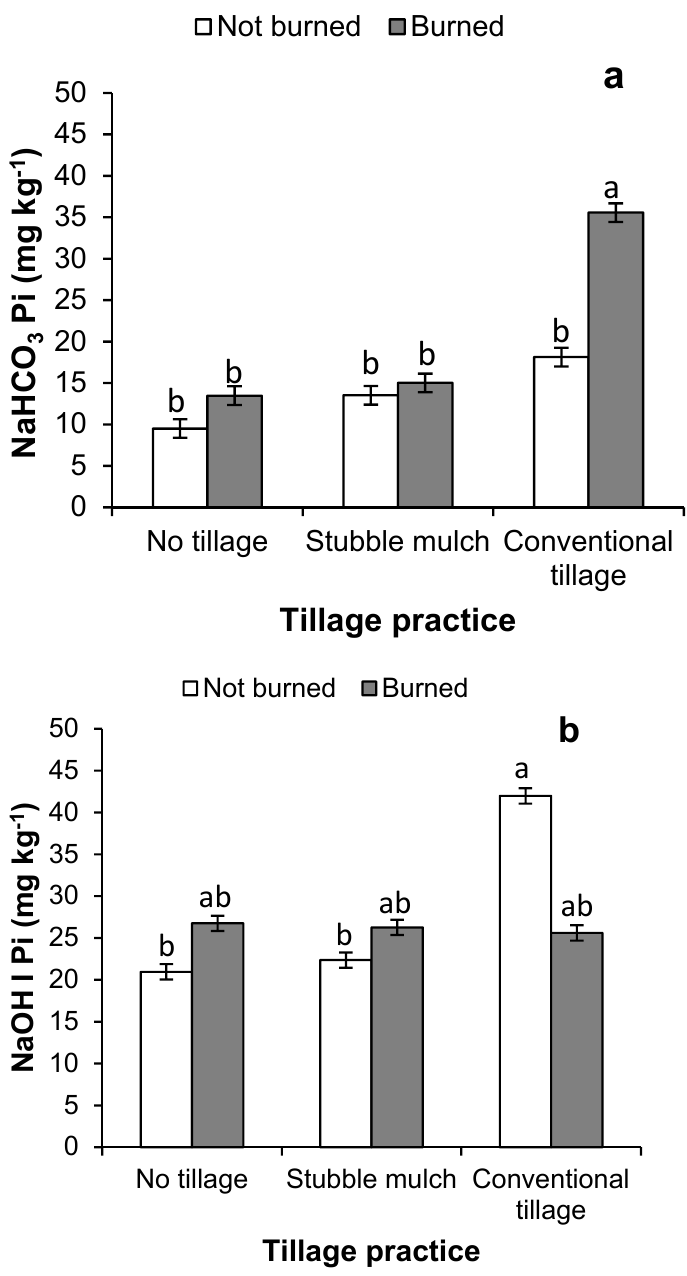
Figure 5. The interaction effect of tillage × straw management on ( a ) NaHCO 3 Pi, ( b ) NaOH I Pi, and fractions (mg kg − 1 ) in the 0–50 mm soil layer. The error bars represent the standard errors of the mean and different letters (a,b) in the bars represent significant differences at p < 0.05 according to Tukey’s multiple comparison test. TheCT(25.7 ± 2.63mgkg − 1 )treatmenthadhigherNaHCO 3 PithanSM(14.0 ± 2.63 mg kg − 1 ) and NT (9.2 ± 2.63 mg kg − 1 ) in the 50–200 (Table 5). The trend of NaHCO 3 was similar in the 200–400 mm but with lower concentrations (Table 5). Burning (19.7 ± 2.15 mg kg − 1